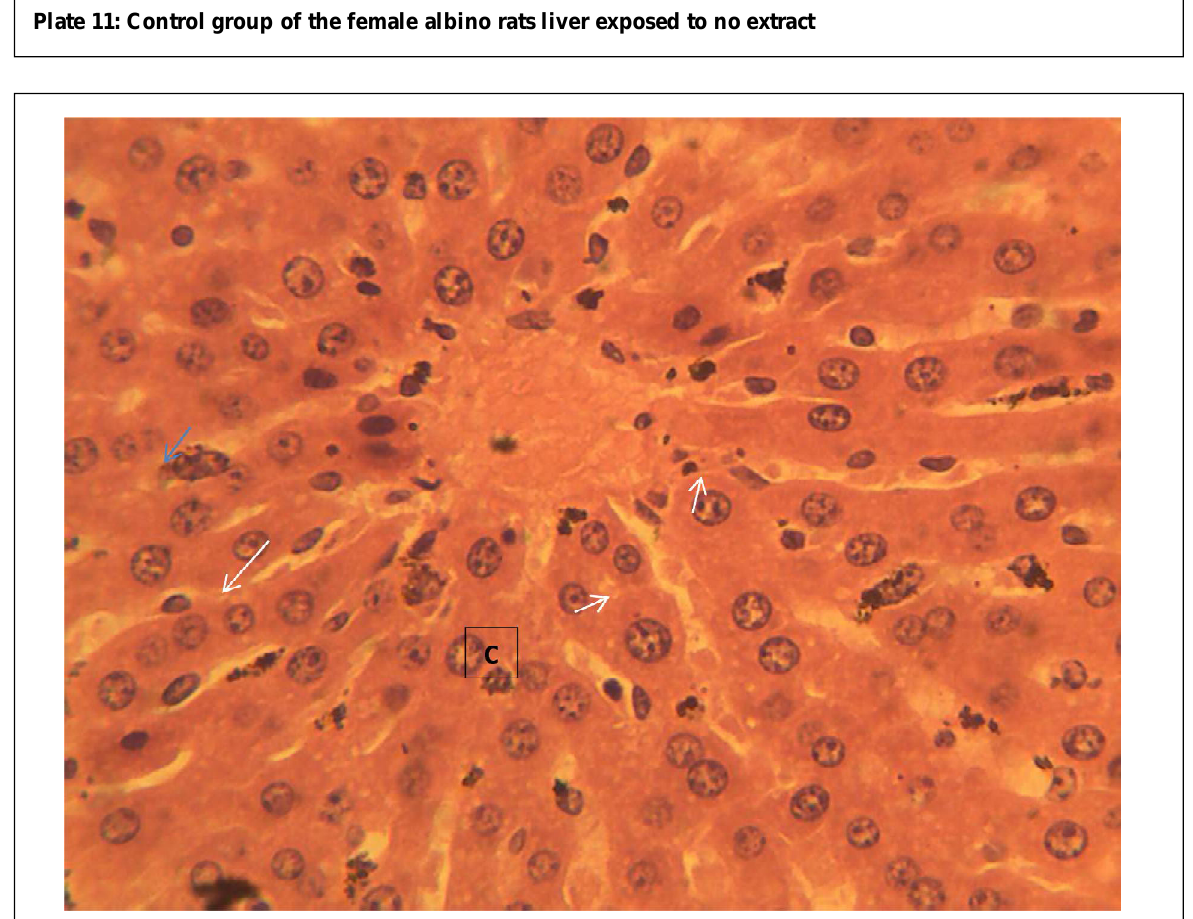
Plate 12: Female liver of the group exposed to 200 mg/kg of aqueous